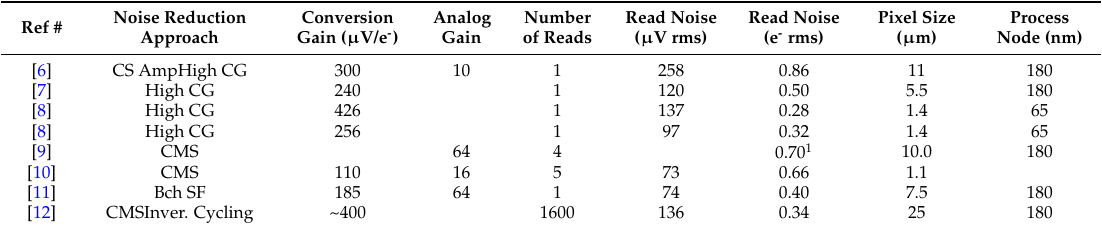
Table 1. Sub 1 e ´ SF read noise results from various